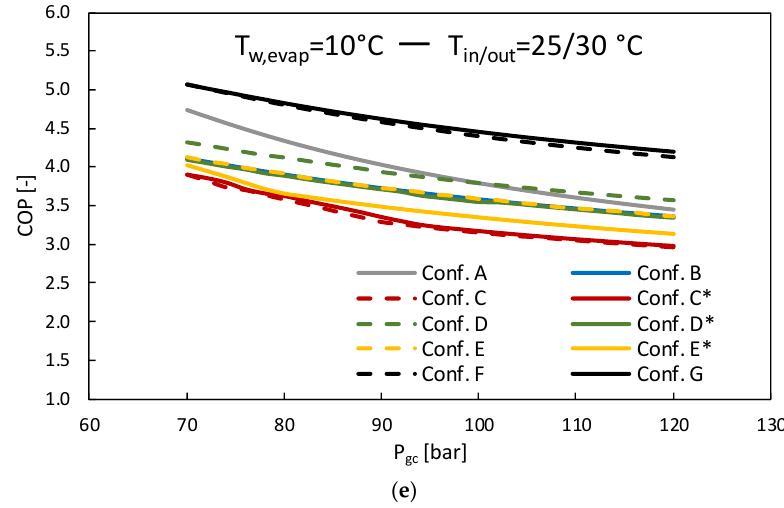
Figure 6. COP vs. gas cooler pressure for the configurations considered for space heating at ( a ) 30/35 Figure 6. Scheme of screening of ion-responsive DNA aptamers targeting B-loop of PPM1D from the °C; ( b ), 40/45 °C; ( c ) 47/55 °C; ( d ) 55/65 °C and ( e ) swimming pool water heating at 25/30 °C. * indi- designed IRDAptamer library. cates a different direction of the water flow within the water lines.